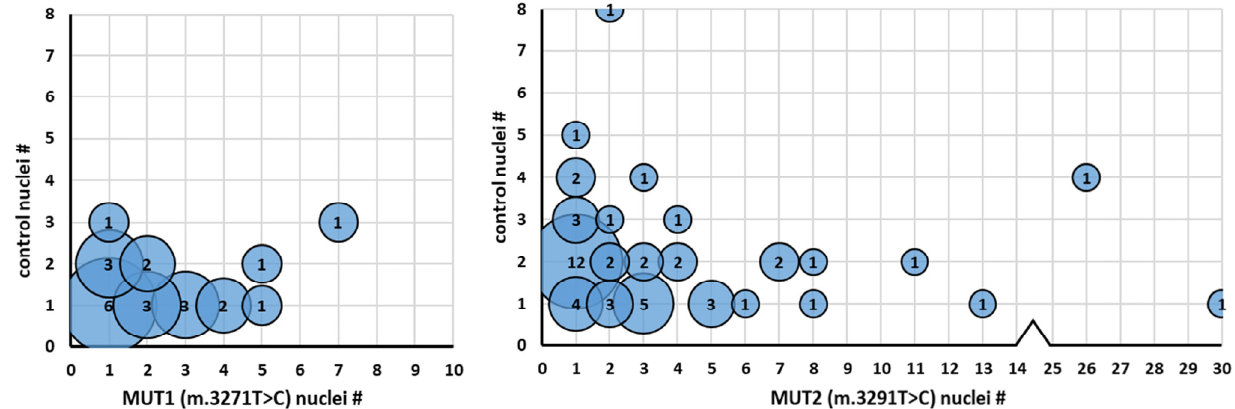
Figure 3. Individual fusion ratios of control MABs with m.3271T>C and m.3291T>C MABs and myotubes. X-axis: number of mutant nuclei per myotube, Y-axis: number of control nuclei per myotube. The number of observations is shown in circles. MUT1: n = 23, MUT2: n = 52.